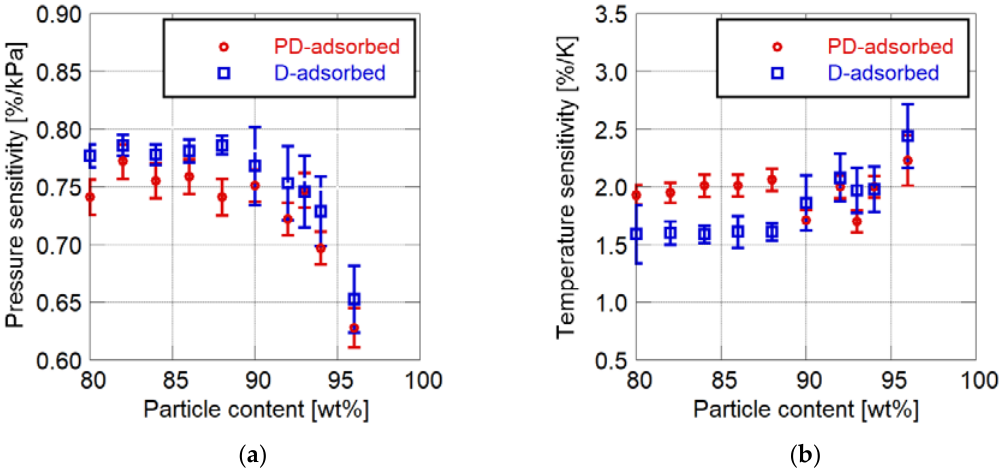
Figure 3. Static sensitivity characteristics related to particle mass content. ( a ) Pressure sensitivity; ( b ) Temperature sensitivity.